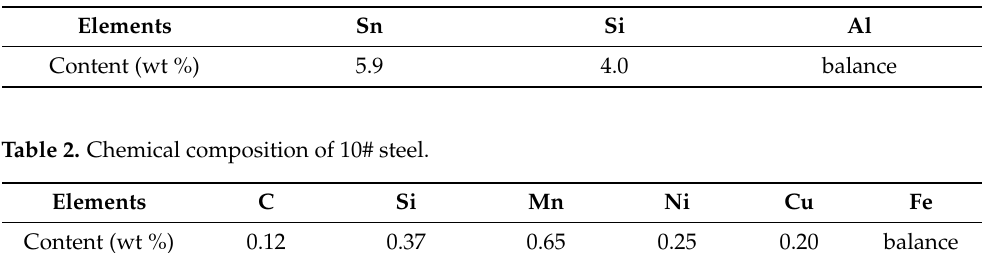
Table 1. Chemical composition of Al-Sn bearing alloy.